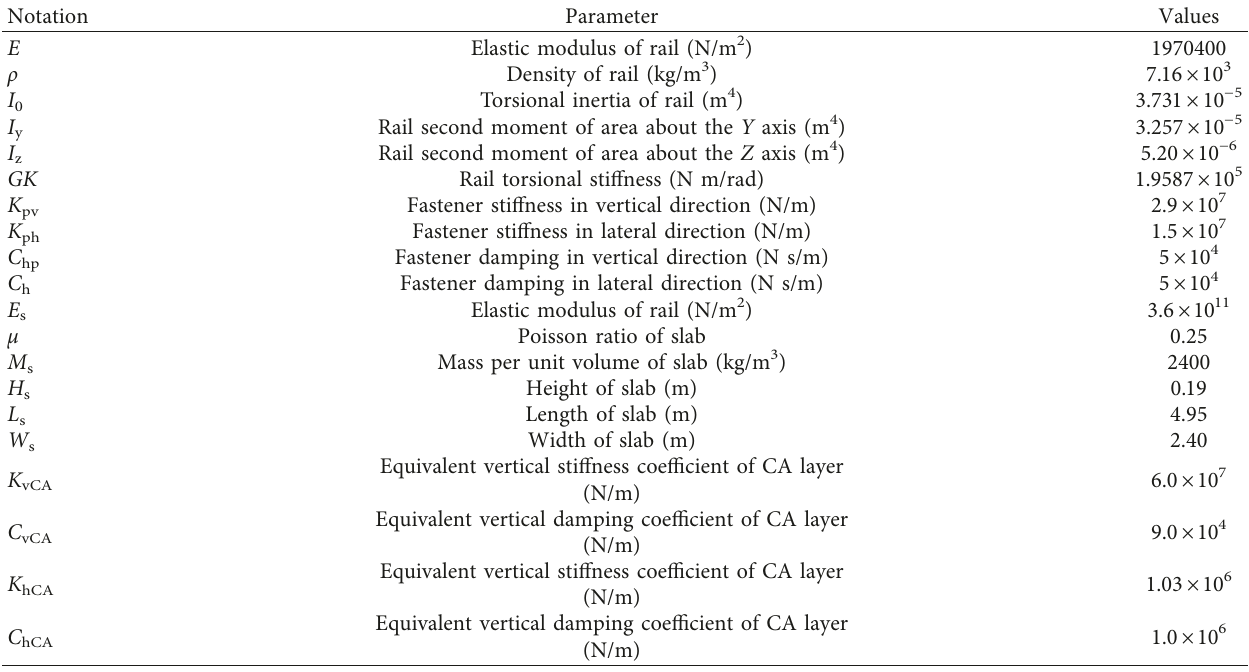
Table 2: Main parameters of railway tracks used in the